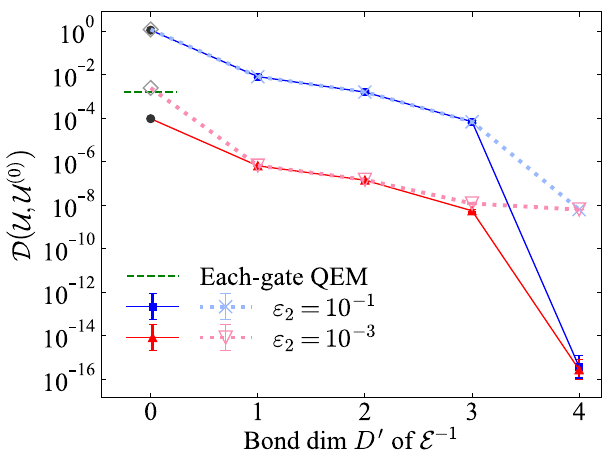
◦ U , U ( 0 ) ) for different bond dimen- FIG. 7. Plot of D ( E − 1 MPO sions D (cid:2) for E − 1 . Here D (cid:2) = 0 corresponds to D ( U , U ( 0 ) ) . Solid MPO and dotted lines describe circuits without and with global N q - qubit depolarizing noise E [ N q ] , respectively, the error rate of which is ε n = 0.01. The system size is N q = 10. For circuits with global noise, we plot the bound of QEM performance if one mit- igates the error of each gate independently, labeled “Each-gate